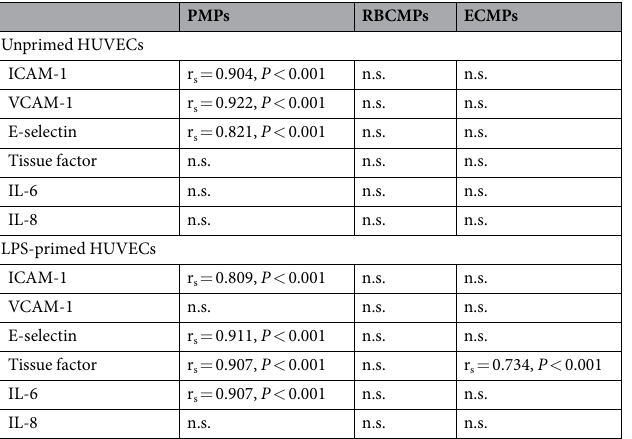
Table 2. Correlation between MPs origin and endothelial cell activation markers. ECMP; endothelial cell- derived MPs, HUVECs; human umbilical vein endothelial cells, ICAM-1; intracellular adhesion molecule-1, IL; interleukin, LPS; lipopolysaccharide, MPs; microparticles, n.s.; not significance, no correlation, PMPs; platelet-derived MPs, RBCMPs; red blood cell-derived MPs, r s ; Spearman’s coefficient correlation and VCAM-1; vascular cell adhesion